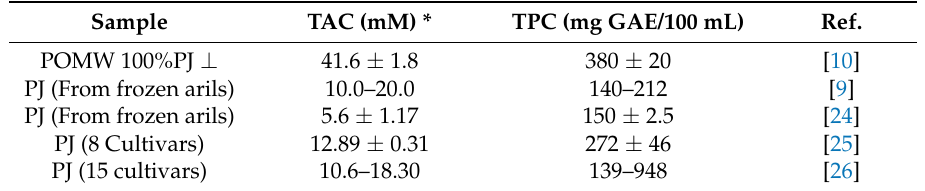
Table 3. Reported total antioxidant capacity and TPC values for pomegranate